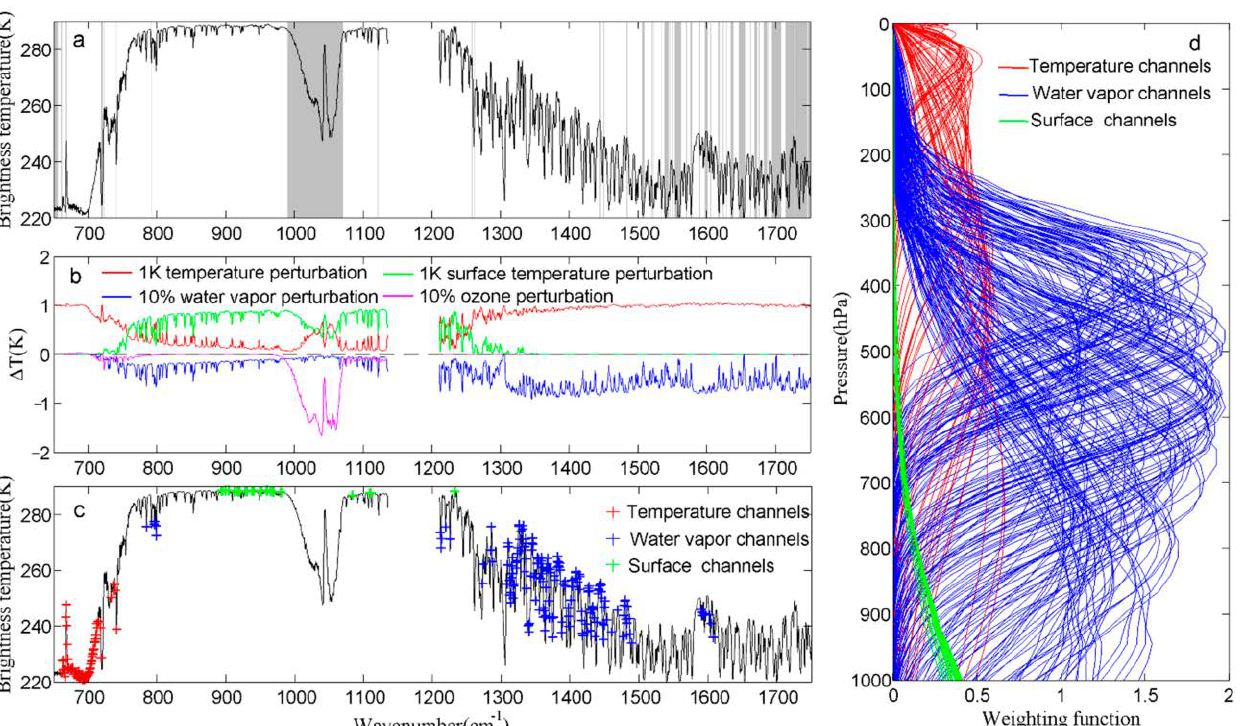
Figure 2. ( a ) The blacklist (grey shaded area) and ( b ) the perturbations of temperature, water vapor, ozone, and surface temperature in the HIRAS LW and MW bands. ( c ) The wavenumbers and ( d ) the weighting functions of all of the selected channels. Red, blue, green, and pink represent the temperature, water vapor, surface temperature and ozone,